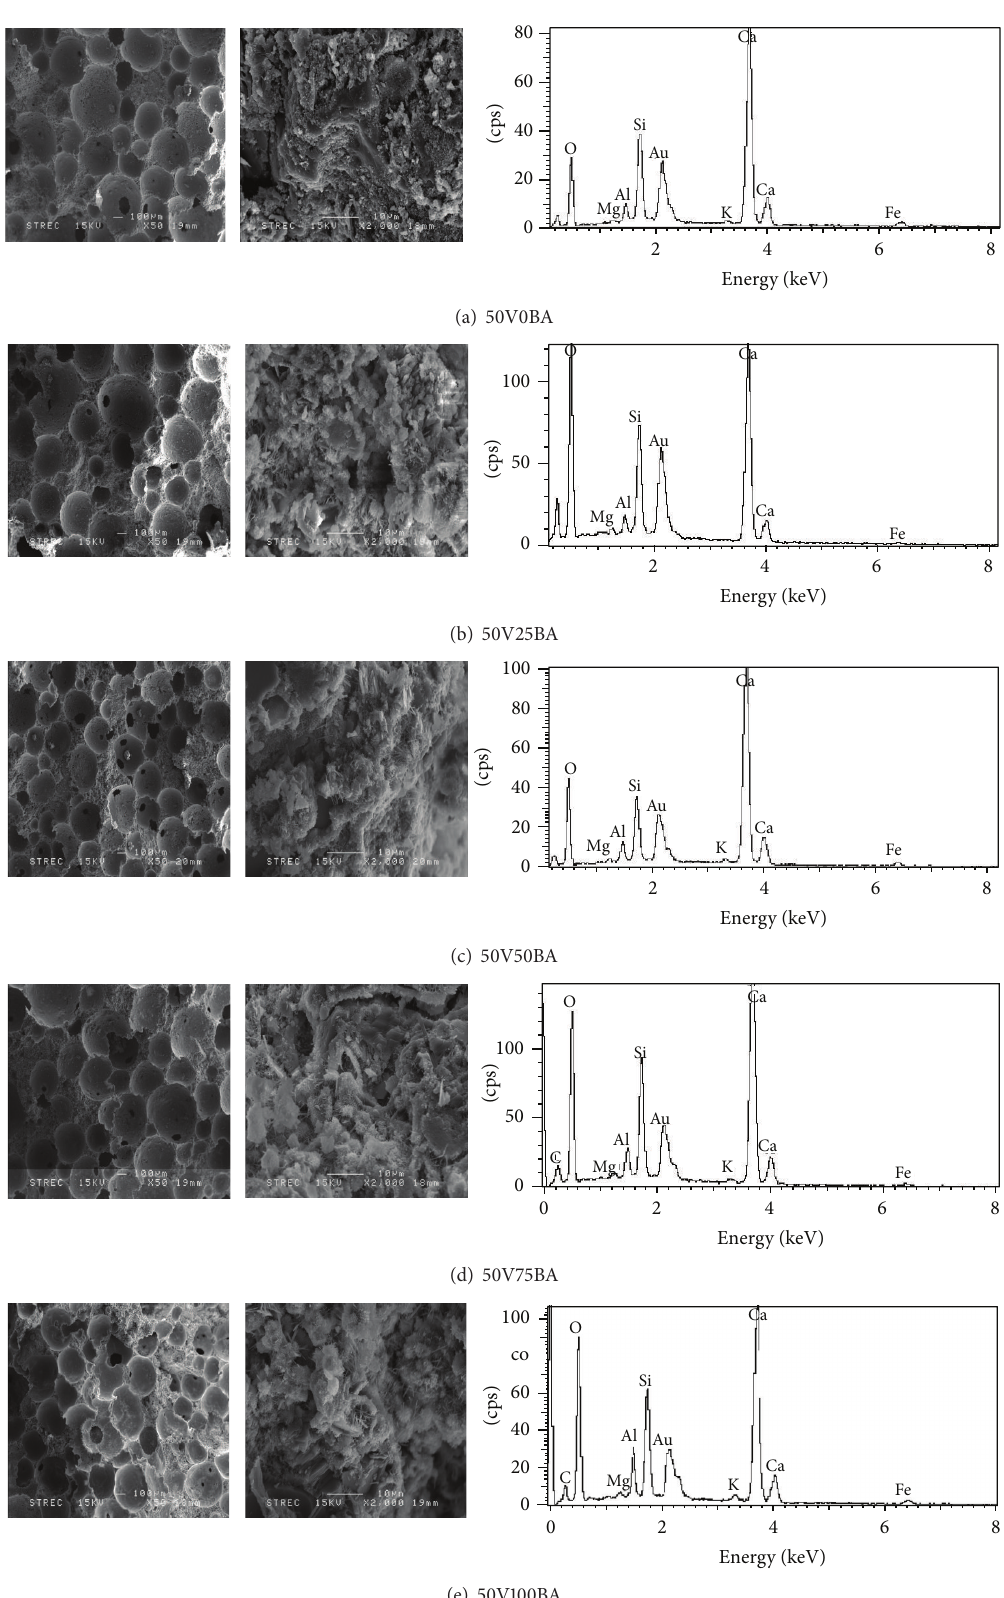
Figure 7: SEM image and EDX spectrum of cellular concrete after 28